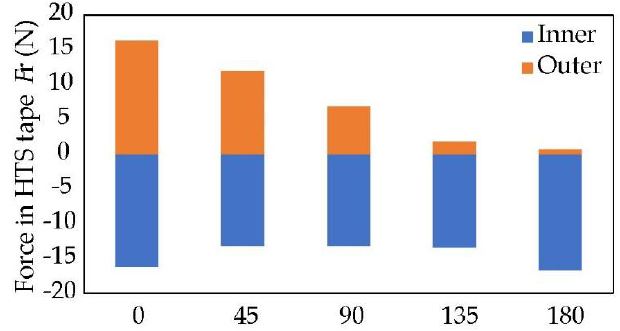
Figure 17. Tensile force in HTS tape during short-circuit.